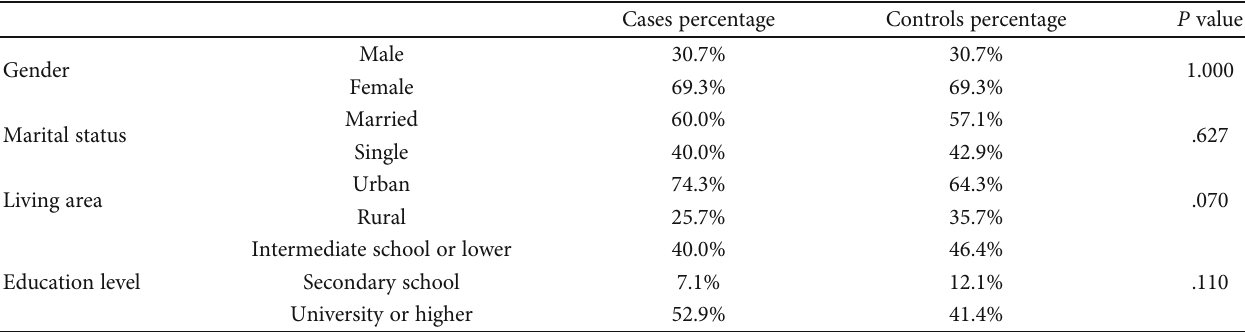
Table 2: Detailed comparison of the demographics between the cases and the controls.